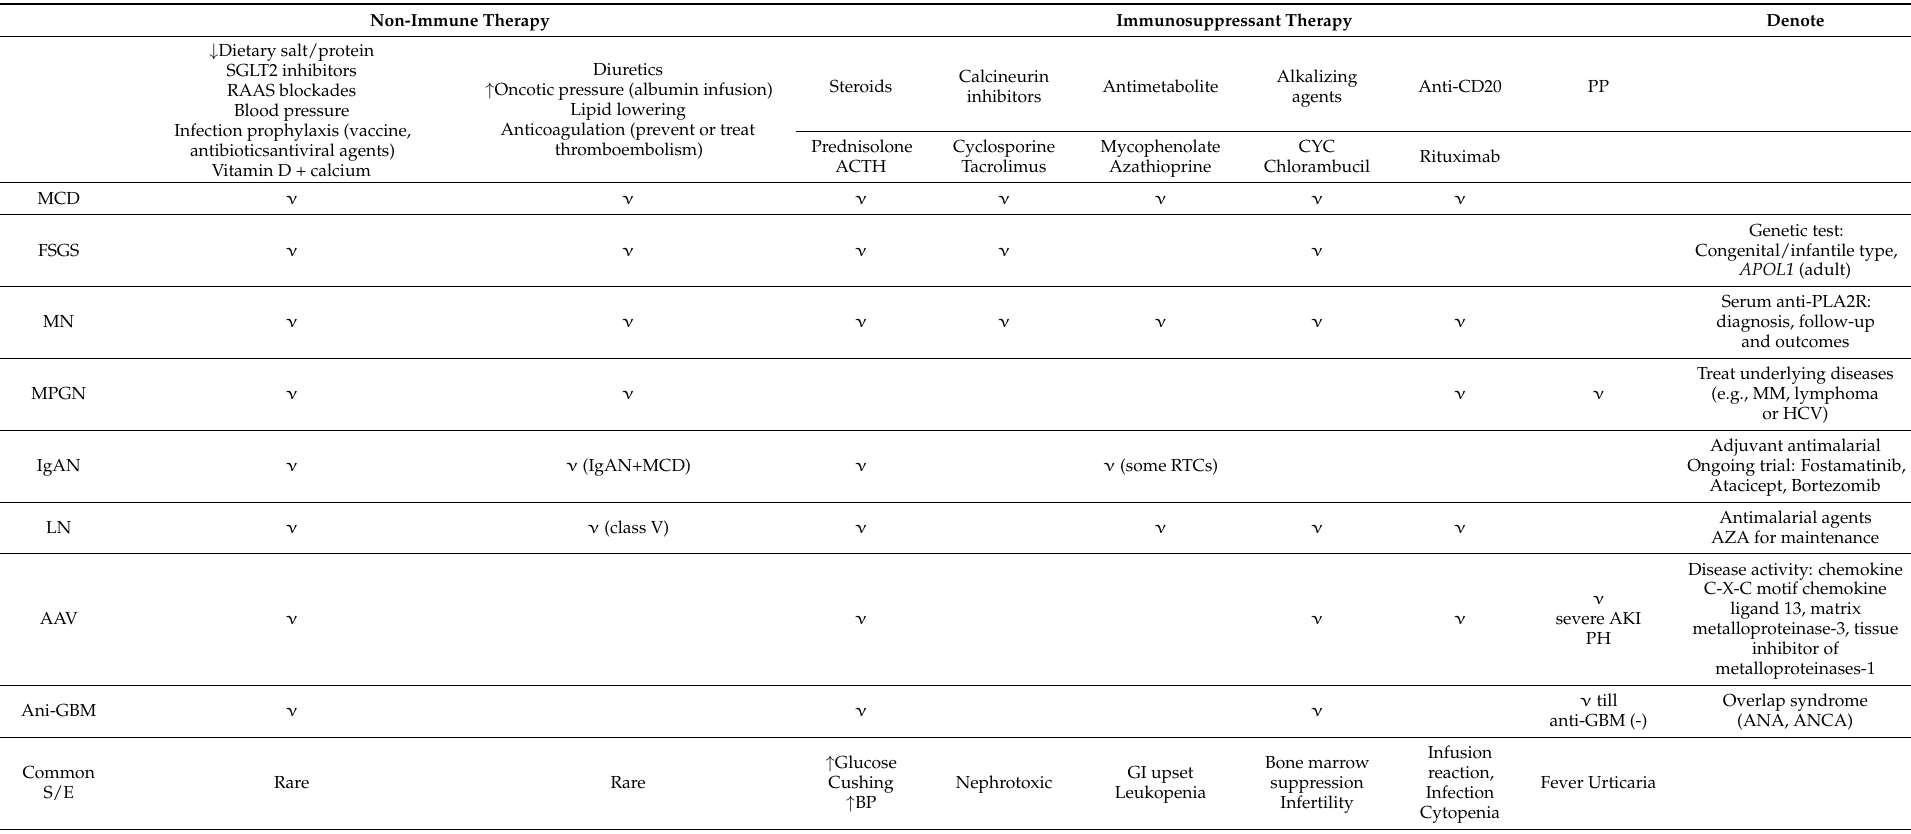
Table 2. The therapy of glomerulopathy and the common side effects of the